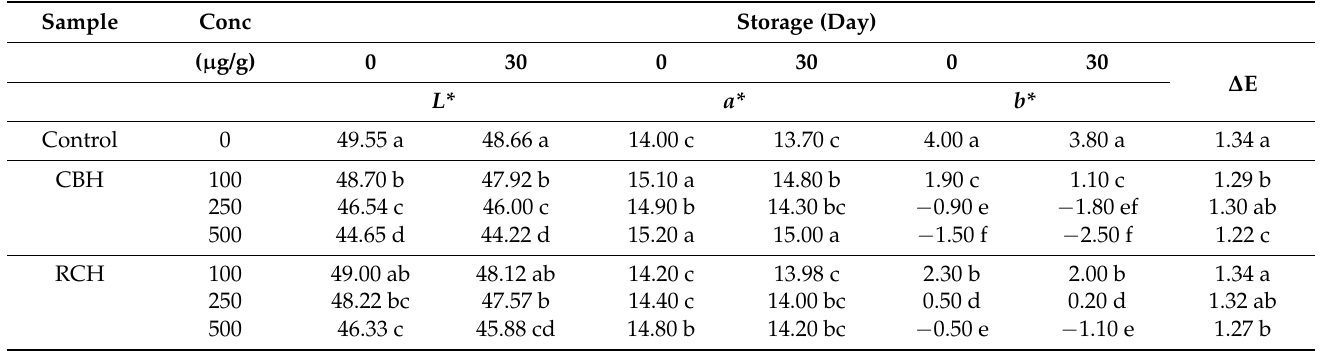
Table 6. The alternation in color parameters in buffalo steak supplemented with CBH and RCH